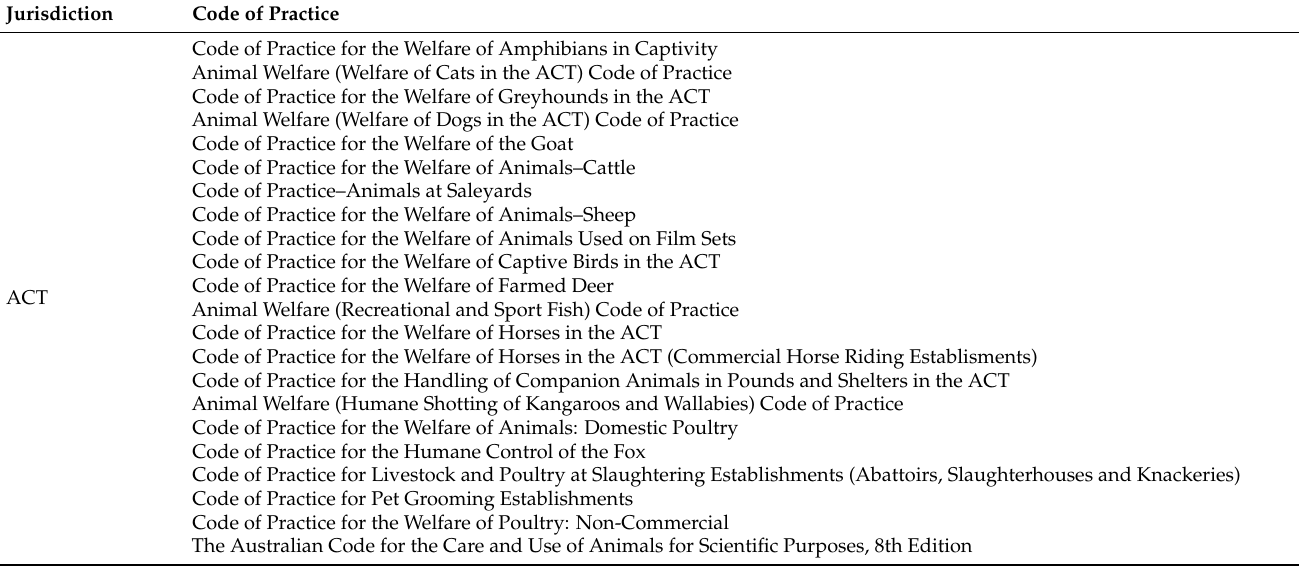
Table A2. Voluntary codes of practices included for analysis (n =